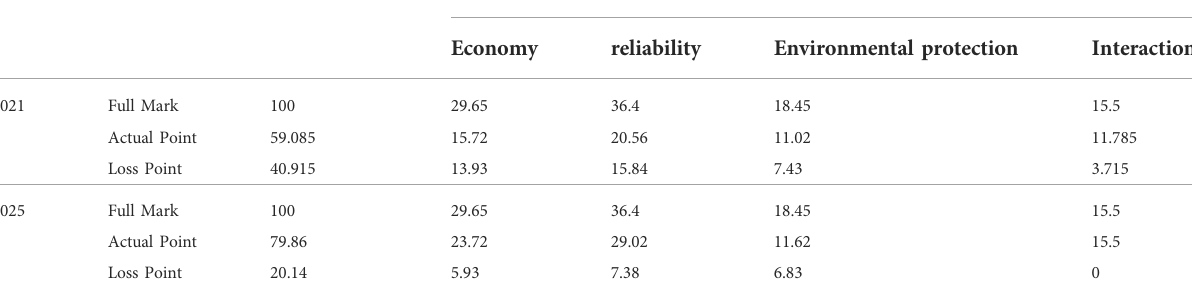
TABLE 2 Distribution network comprehensive score of Yichang in